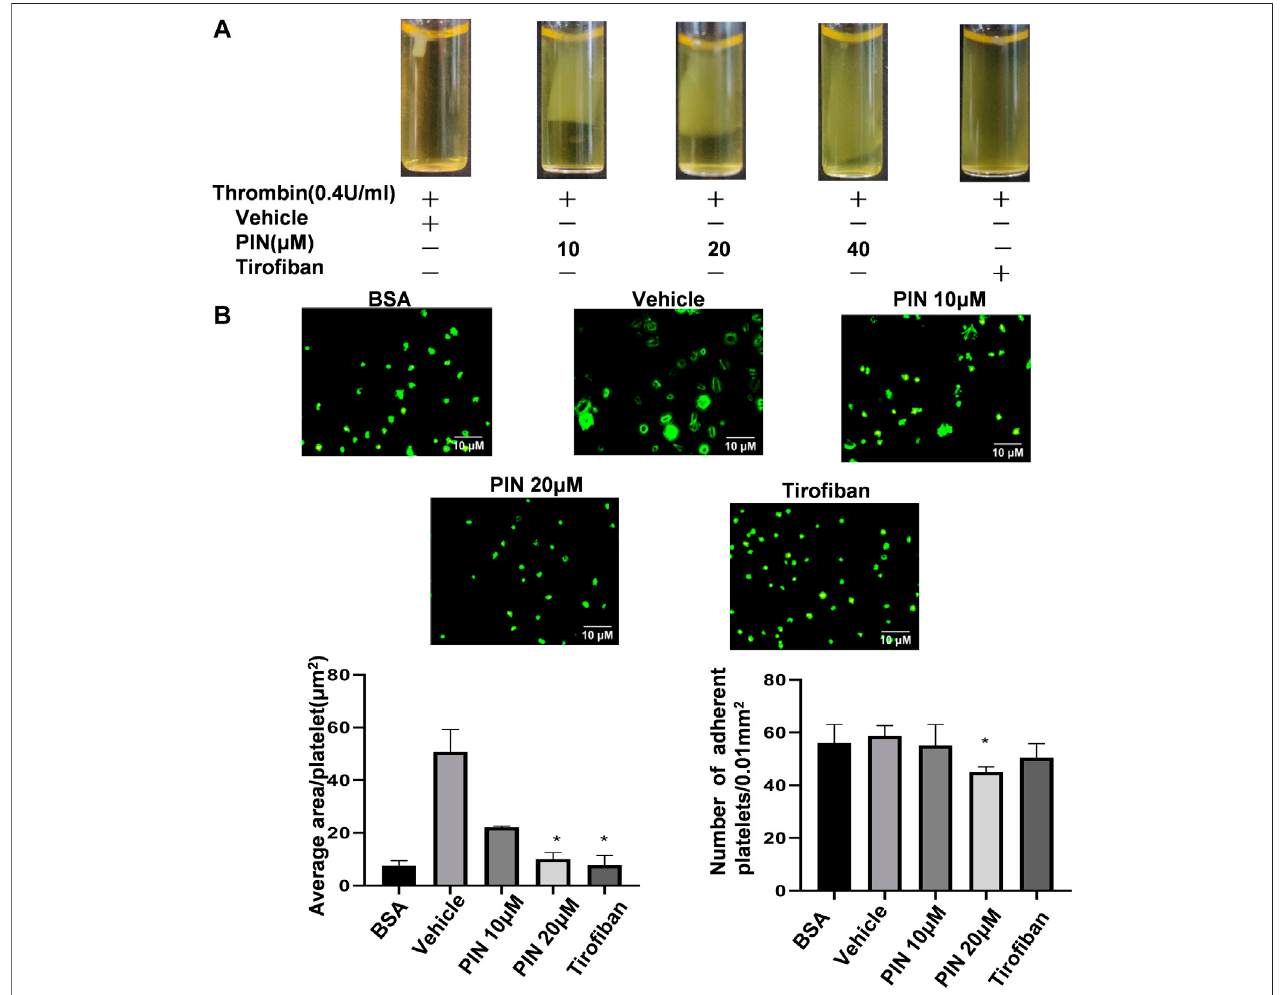
FIGURE 3 | The effect of pimpinellin on clot retraction and platelet spreading on fi brinogen surfaces. (A) Human platelet-rich plasma were treated with pimpinellin (10,20and40 μ M)at37 ° Cfor5 min.Theclotretractionwastriggeredbyaddingthrombin(0.4U/ml)andproceedingat37 ° C.Theclotretractionwasphotographedafter 30 min. (B) Human washed platelets (1.0 × 10 7 /ml) were pretreated with pimpinellin (10 and 20 μ M) or vehicle at 37 ° C for 5 min, and then allowed to adhere to the fi brinogen-coated glass slide. Platelets were spread on a slide coated with fi brinogen at 37 ° C for 60 min, after which spreading was stopped by fi xing in 4% paraformaldehyde. The platelet images were obtained by fl uorescent microscopy. Representative images were obtained from three similar experiments. Data are presented as the mean ± SEM ( n (cid:2) 3). * p < 0.05 and ** p < 0.01 compared to the vehicle group.